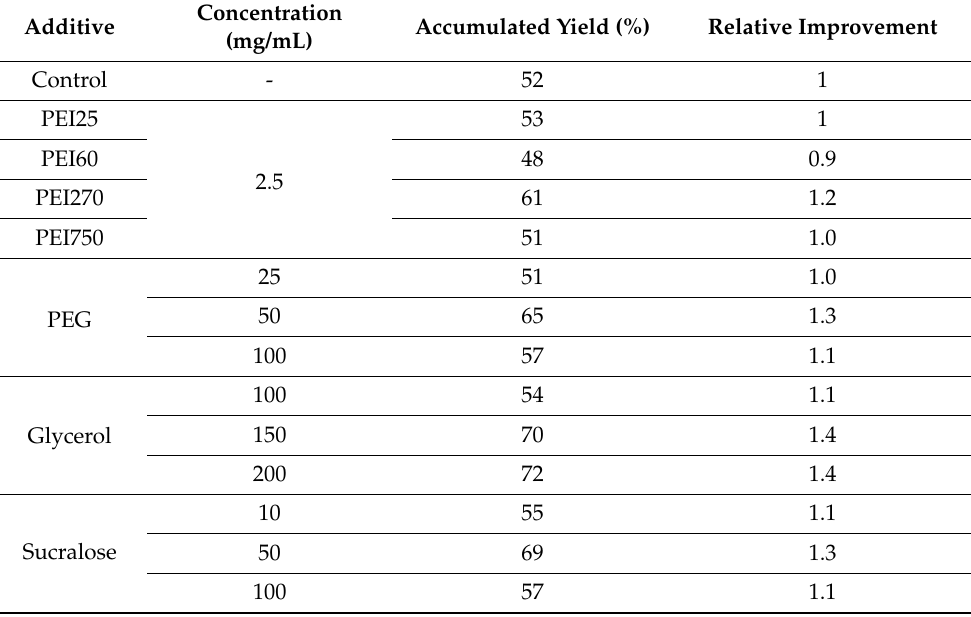
Table 2. Effect of different stabilising agents on the overall yield after 3 cycles of the dialysis as ‐ sisted scale up. Reactions consisted of 4 mL of 10 mM cinnamaldehyde, 1 eq. of L ‐ alanine, 250 mM